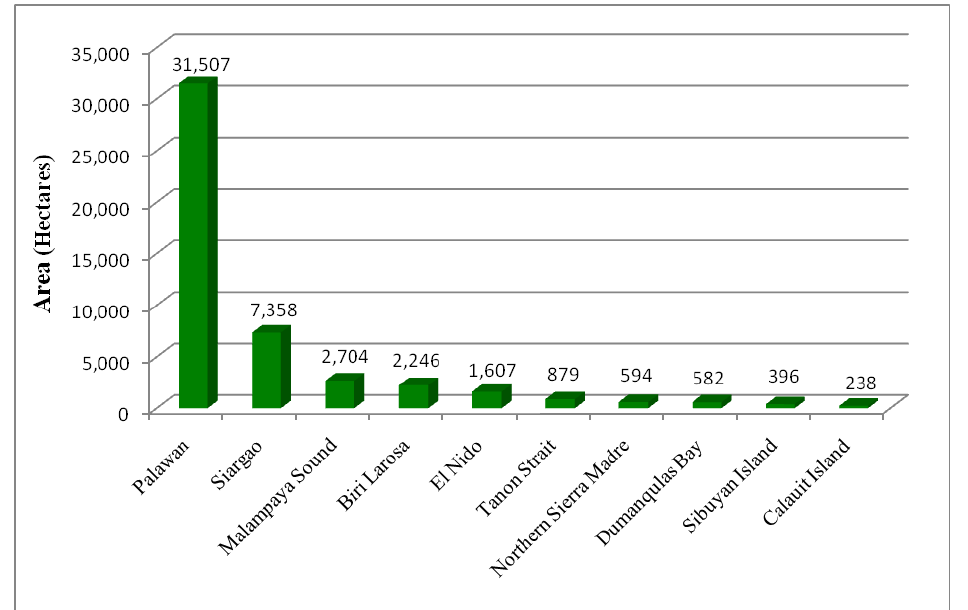
Figure 8. Mangrove protected aeas under IUCN delineated protected areas